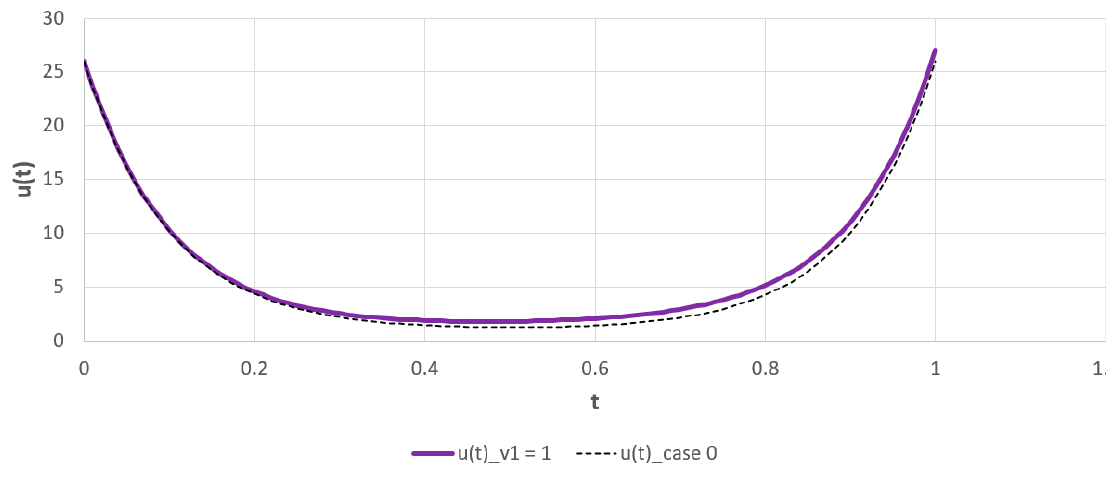
Figure 21. The optimal time path of u in Dynamic case 5.